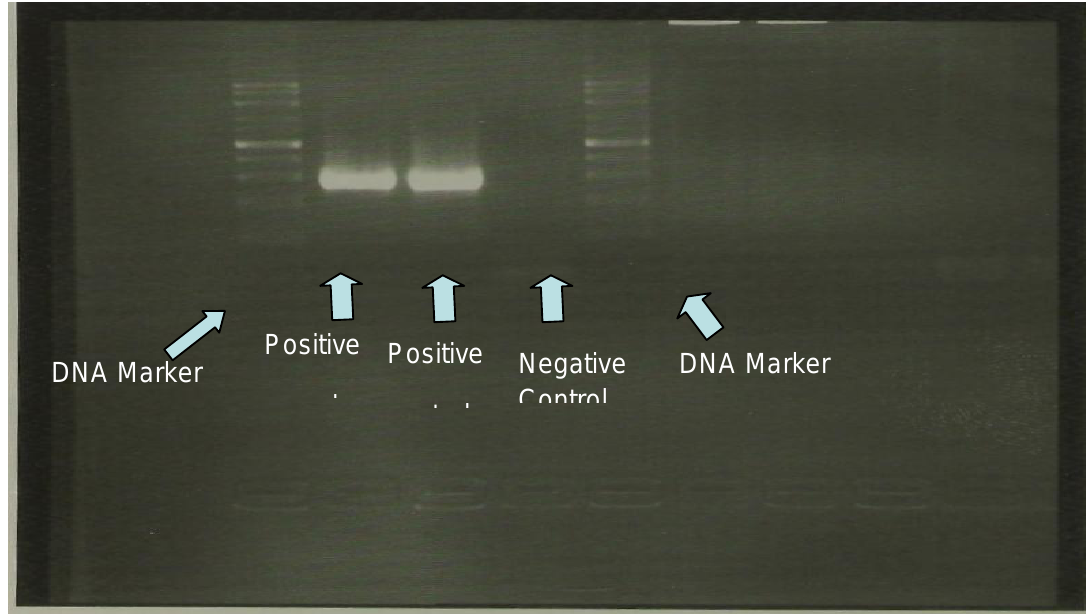
Fig. 1. sensitivity of PCR using cell lysate, followed by agarose gel electrophoresis. Lane 1 DNA Marker (100bp), Lane 2 Positive sample, Lane 3 Positive control, Lane 4 Negative control, Lane 5 DNA